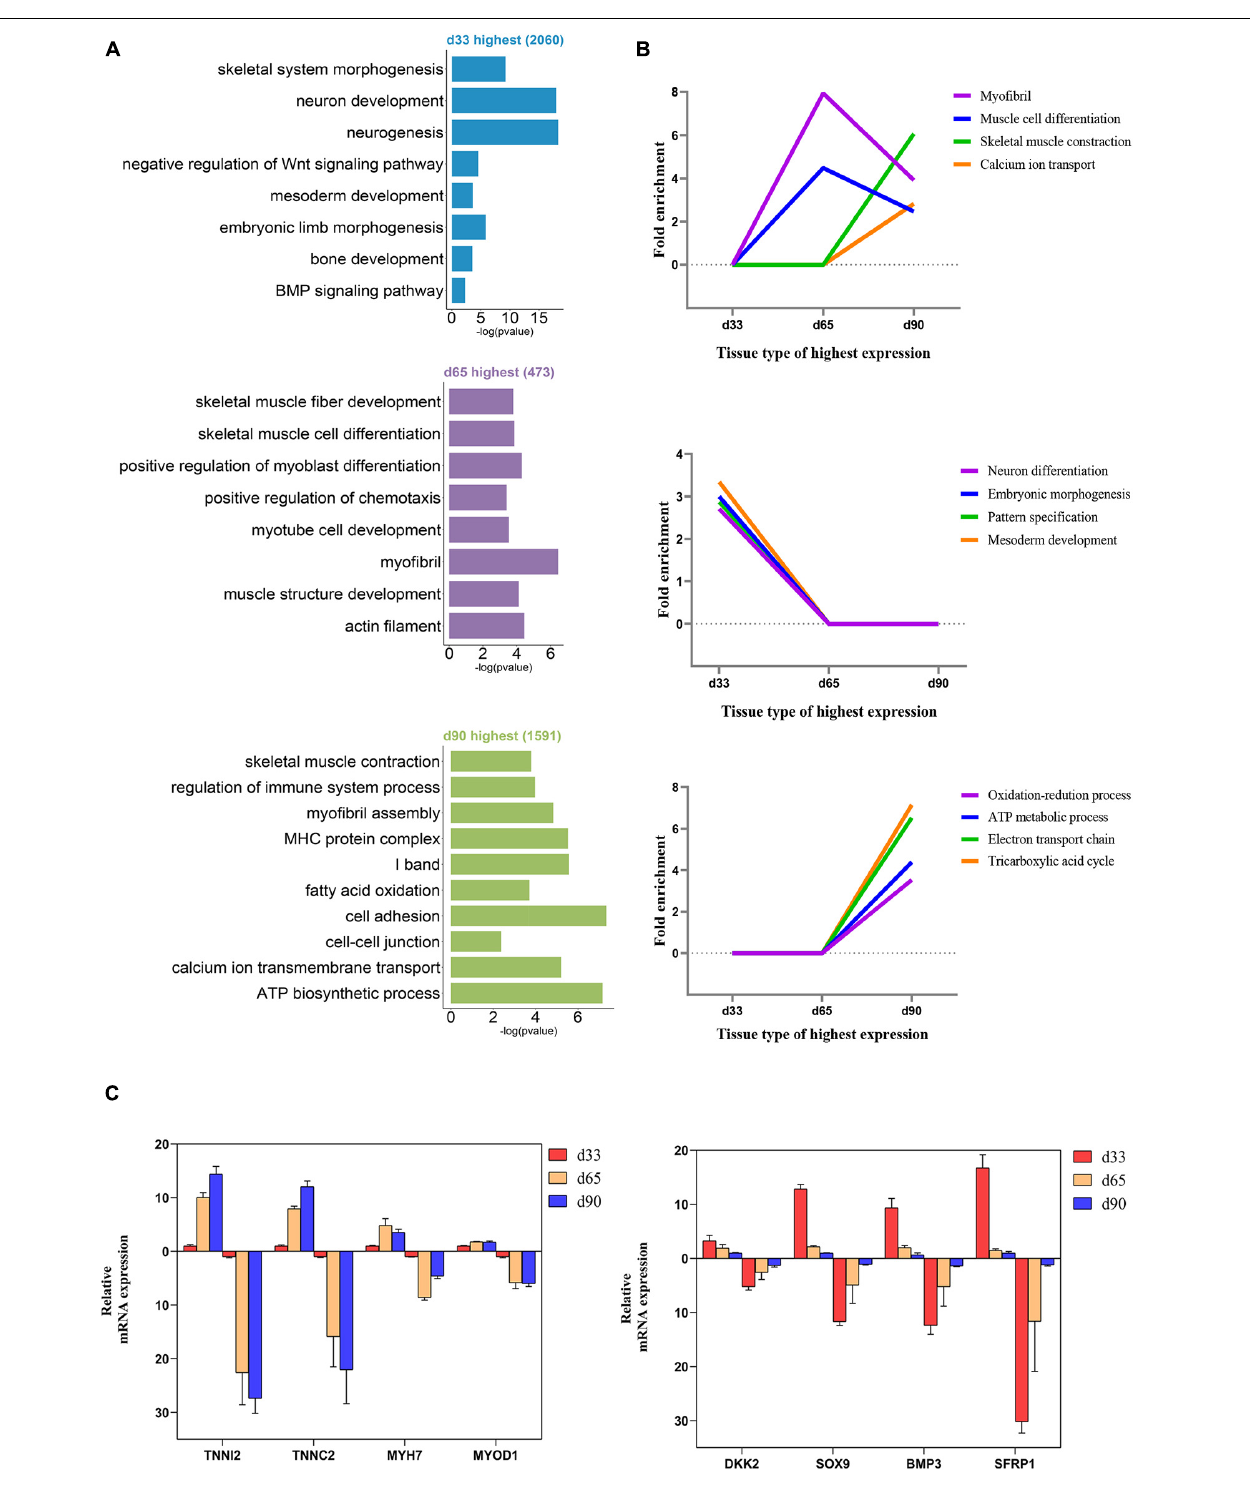
FIGURE 2 | Functional enrichment analysis of differentially expressed genes. (A) The GO enrichment analysis of DEGs expressed at the highest level in the three stages. (B) Fold enrichment of genes for the presented GO terms. Fold enrichment is the proportion of term genes found in the DEGs list compared to the proportion of total term genes found in the background. (C) Validation of the expression of DEGs using RT-qPCR (the above of the x -axis represents the results of RT-qPCR; the below of the x -axis represents the results of RNA-seq).